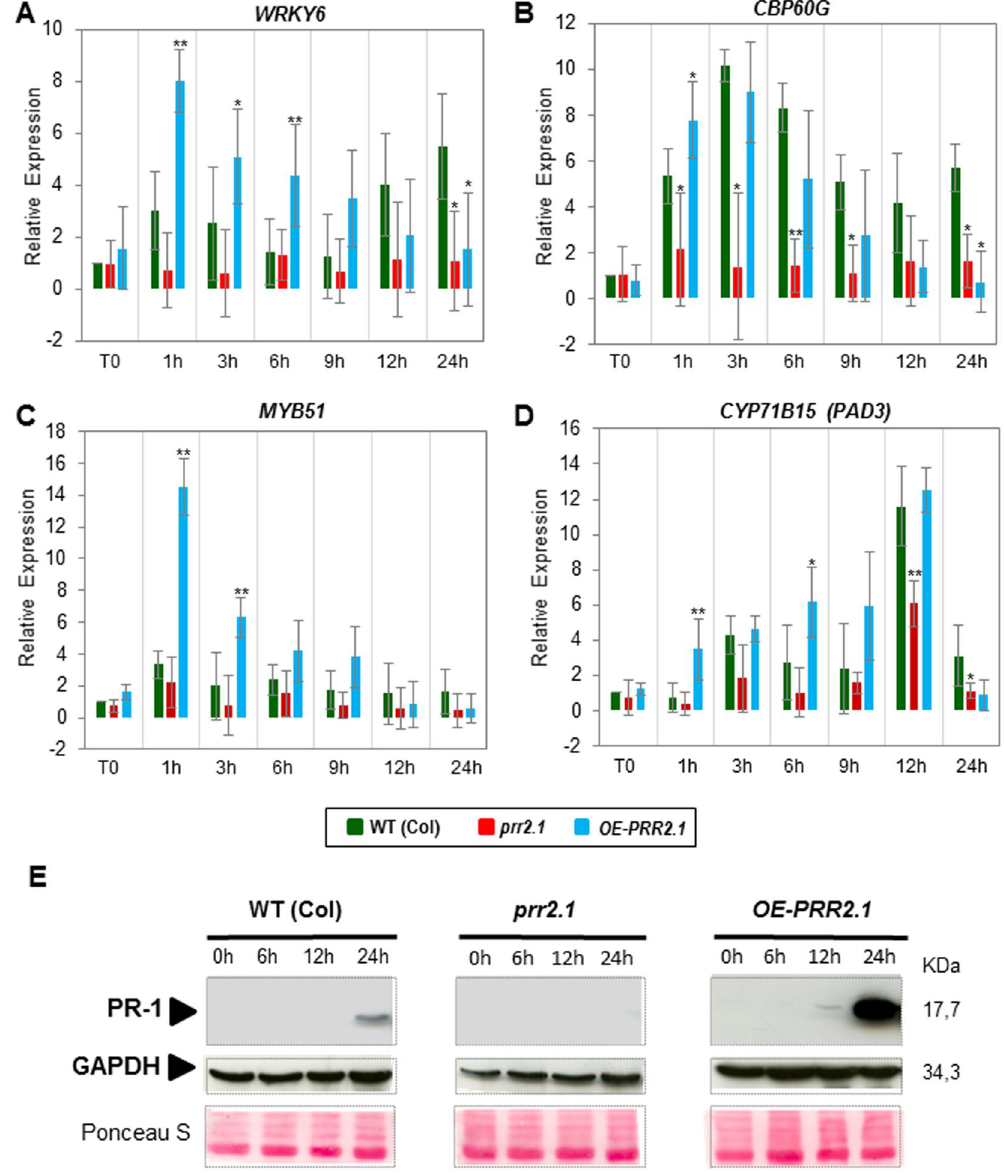
Figure 4. Expression analysis of defence marker genes and detection of PR1 protein in prr2 knock-down mutants and in transgenic line overexpressing PRR2 . ( A , B , C and D ) Analyses of WRKY6 ( A ), CBP60G ( B ), MYB51 ( C ), CYP71B15/PAD3 ( D ) marker genes in different prr2 genetic backgrounds. Leaves of 4-week-old Arabidopsis WT (Col), mutant prr2 . 1 , and OE-PRR2 . 1 were inoculated with 5 × 10 7 cfu.mL − 1 of Pst DC3000 and harvested at 0, 1, 3, 6, 9, 12 and 24 hours post-inoculation (hpi). The fold changes relative to the mock treatment were determined by RT- Q PCR. The values are means ± standard deviation of three independent experiments. Asterisks ( * ) above histograms indicate significant changes of PRR2 gene expression in these different genetic backgrounds compared to WT (Col) (student t-test with p-value < 0.05 ( * ) or p-value 0.01 ( ** )). ( E ) Detection of PR1 by immunoblot experiment in WT plants and prr2 genotypes. PR1 accumulation was detected in leaves of 3-week-old plants at 0, 6, 12, 24 hpi after spraying with Pst DC3000 (2 × 10 8 cfu.mL − 1 ). Equal loading was confirmed by immunoblot detection of GAPDH and Ponceau S staining of the membrane (middle and lower panels). The illustrated blot is representative of three biological